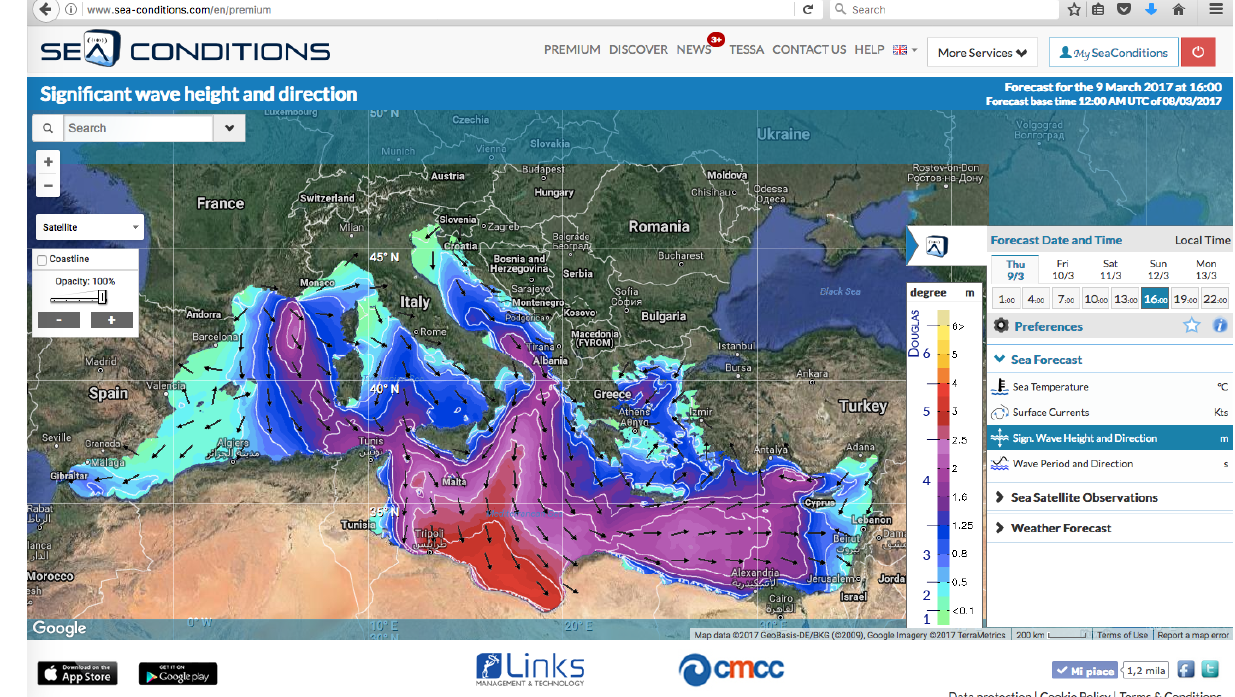
screen, which enables users to easily browse the forecast in- formation directly on the